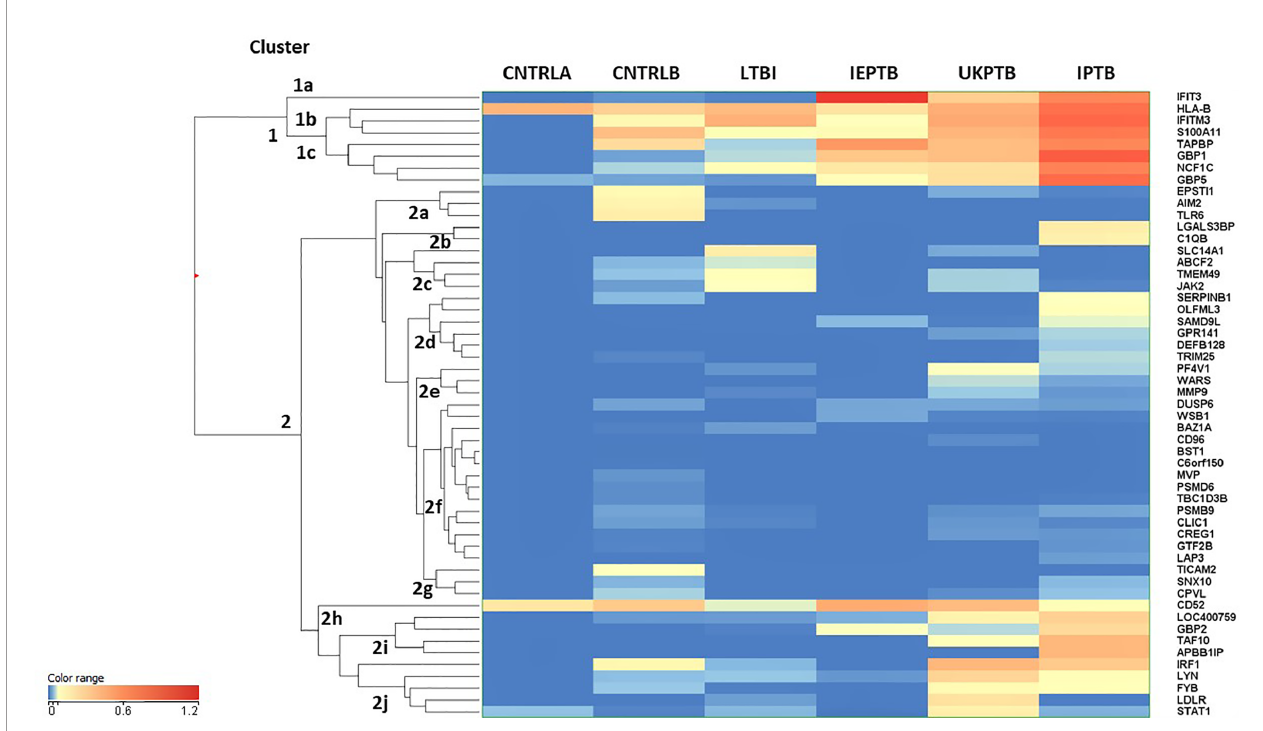
FIGURE 1 | Cluster analysis on all fi fty-three signi fi cant, fi ltered entities on group averaged data CNTRLA - low TB incidence region UK control group CNTRLB - low TB incidence region UK control group from the PREDICT TB study group LTBI - low TB incidence region LTBI from the PREDICT TB study group IEPTB - high TB incidence region extra-pulmonary TB group UKPTB - low TB incidence region UK TB group IPTB - high TB incidence region Indian pulmonary TB